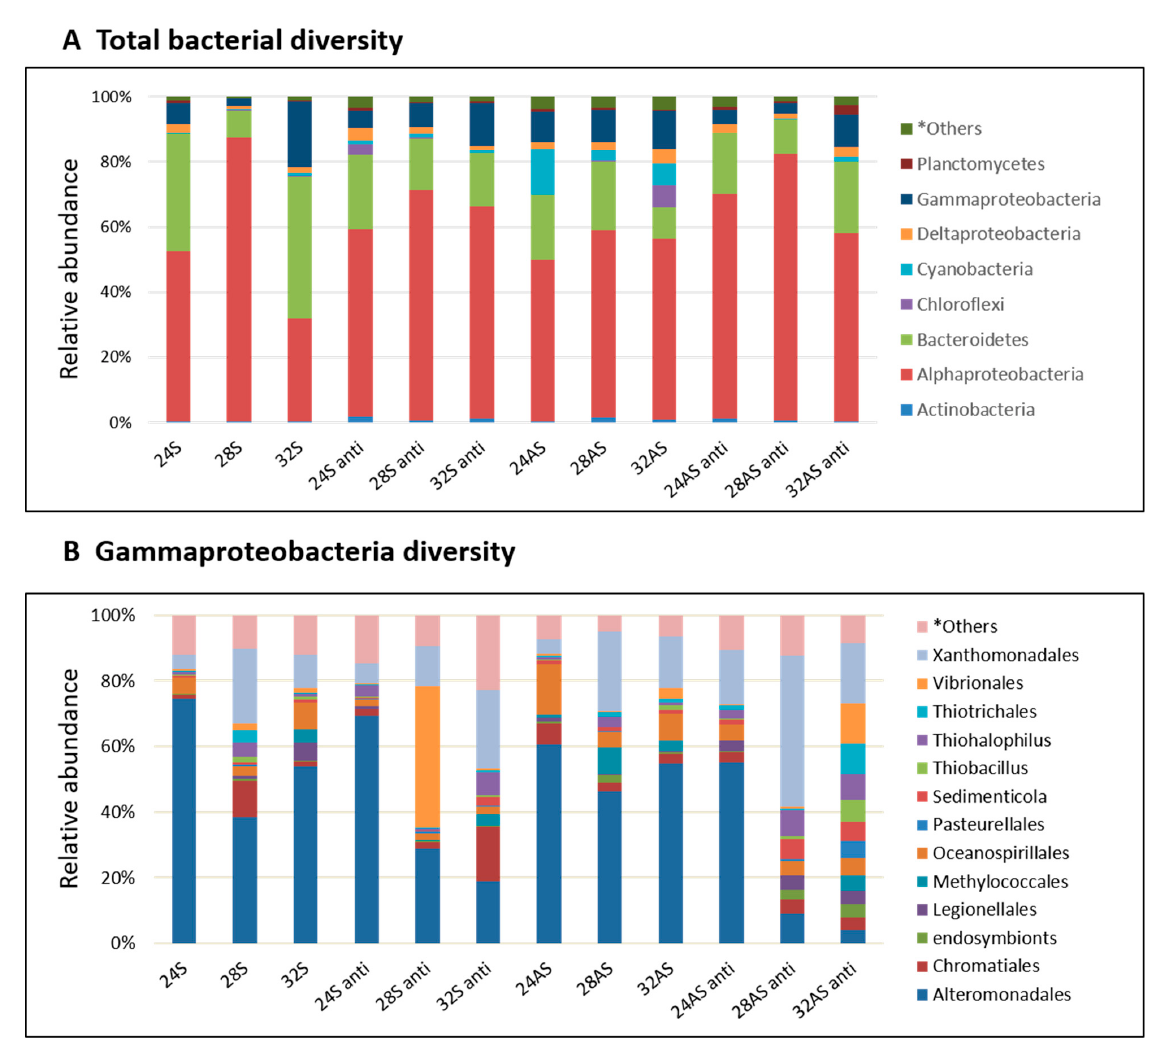
Figure 3. Bacterial composition and relative abundance of symbiotic and apo ‐ symbiotic E. paradivisa samples (12 treatments). ( A ) total bacterial diversity divided by phylum and ( B ) Gammaproteobacteria class diversity divided by order. *Others includes all groups under 2%.